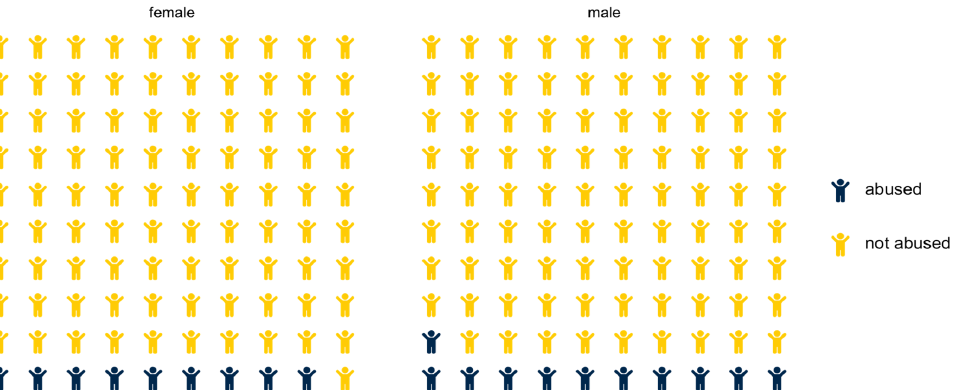
Figure 3. Physical Abuse Among Hypothetical Samples of 100 Children at Mean Levels of Gender Inequality. Note: Results suggest that at mean levels of GII, 11 male children and 9 female children would be subject to abuse. Were a similar figure to be constructed for countries where GII was 1 standard deviation above the mean, 17 male children and 16 female children would be subject to abuse. At 1 standard deviation below the mean, 7 male children and 5 female children would be subject to